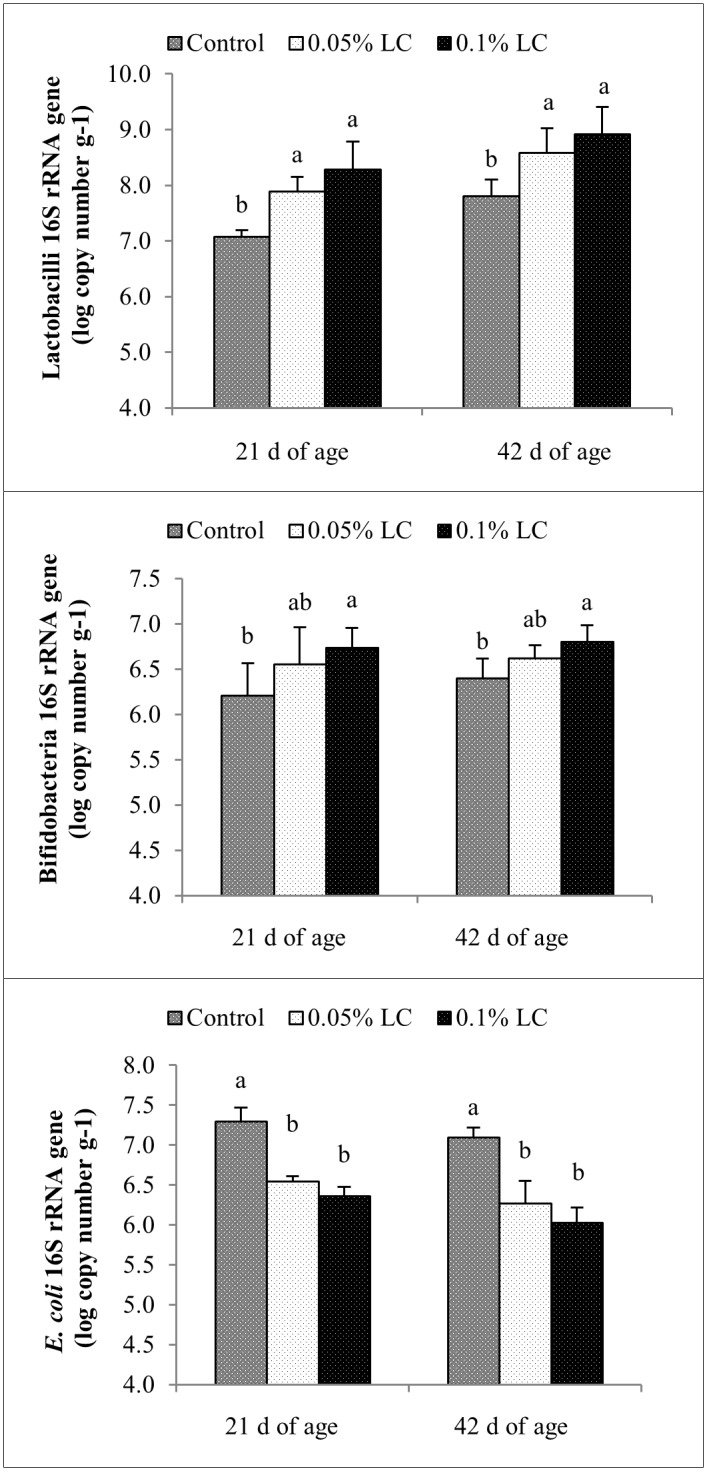
Effects of dietary supplementations of a mixture of L. salivarius strains (LC) on populations of cecal lactobacilli, bifidobacteria and E. coli of broiler chickens at 21 and 42 d of age quantified using real-time PCR and expressed as log10 copy number g-1.Columns represent means of six birds in each treatment group (one chicken per replicate cage) ± SD. Within each period, columns with different letters differ significantly (P < 0.05). Control, basal diet; 0.05% LC, basal diet + 0.5 g kg-1 LC; 0.1% LC, basal diet + 1 g kg-1 LC.